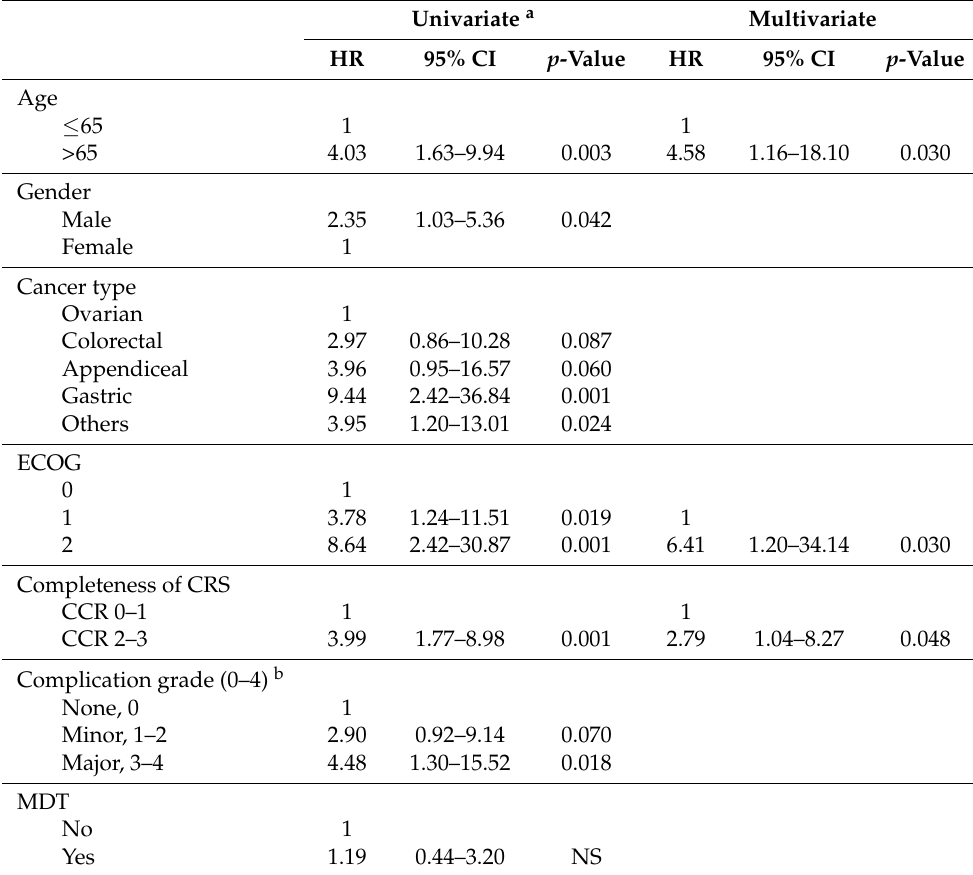
Table 5. Univariate and multivariate analyses of significantly prognostic factors on survival for the patients after CRS–HIPEC by cox